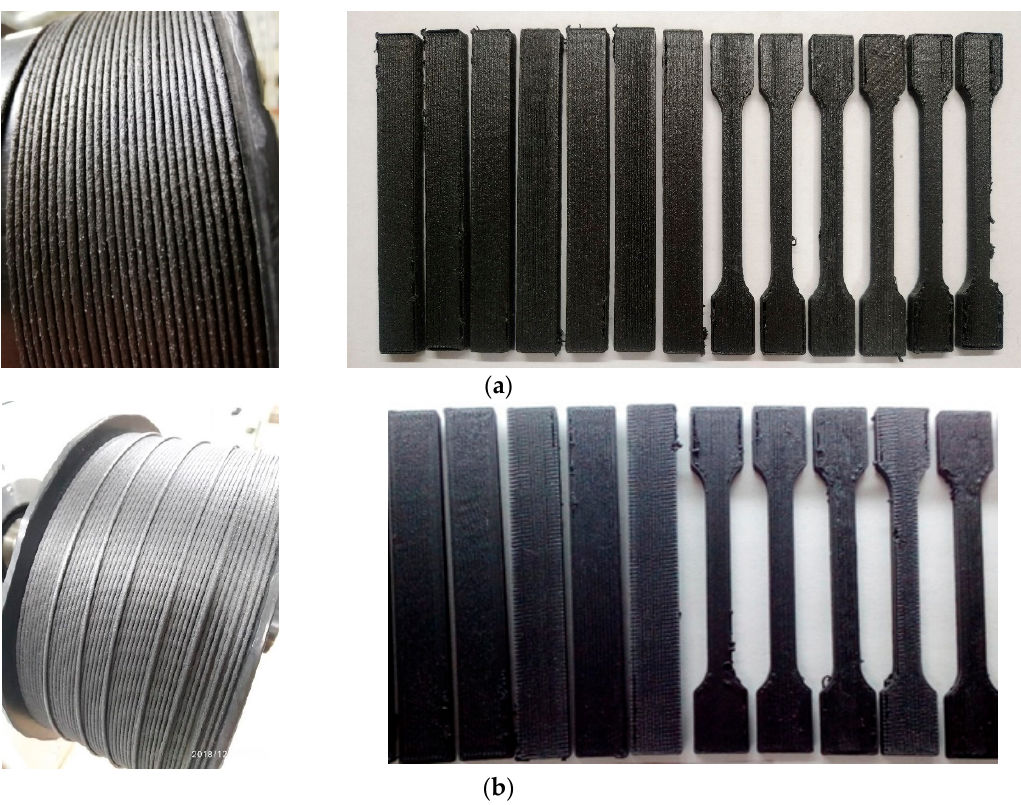
Figure 10. Composite filament for printing and printed test specimens: PEI/CF/OPSU ( a ); PEI/CF/PC ( b ).